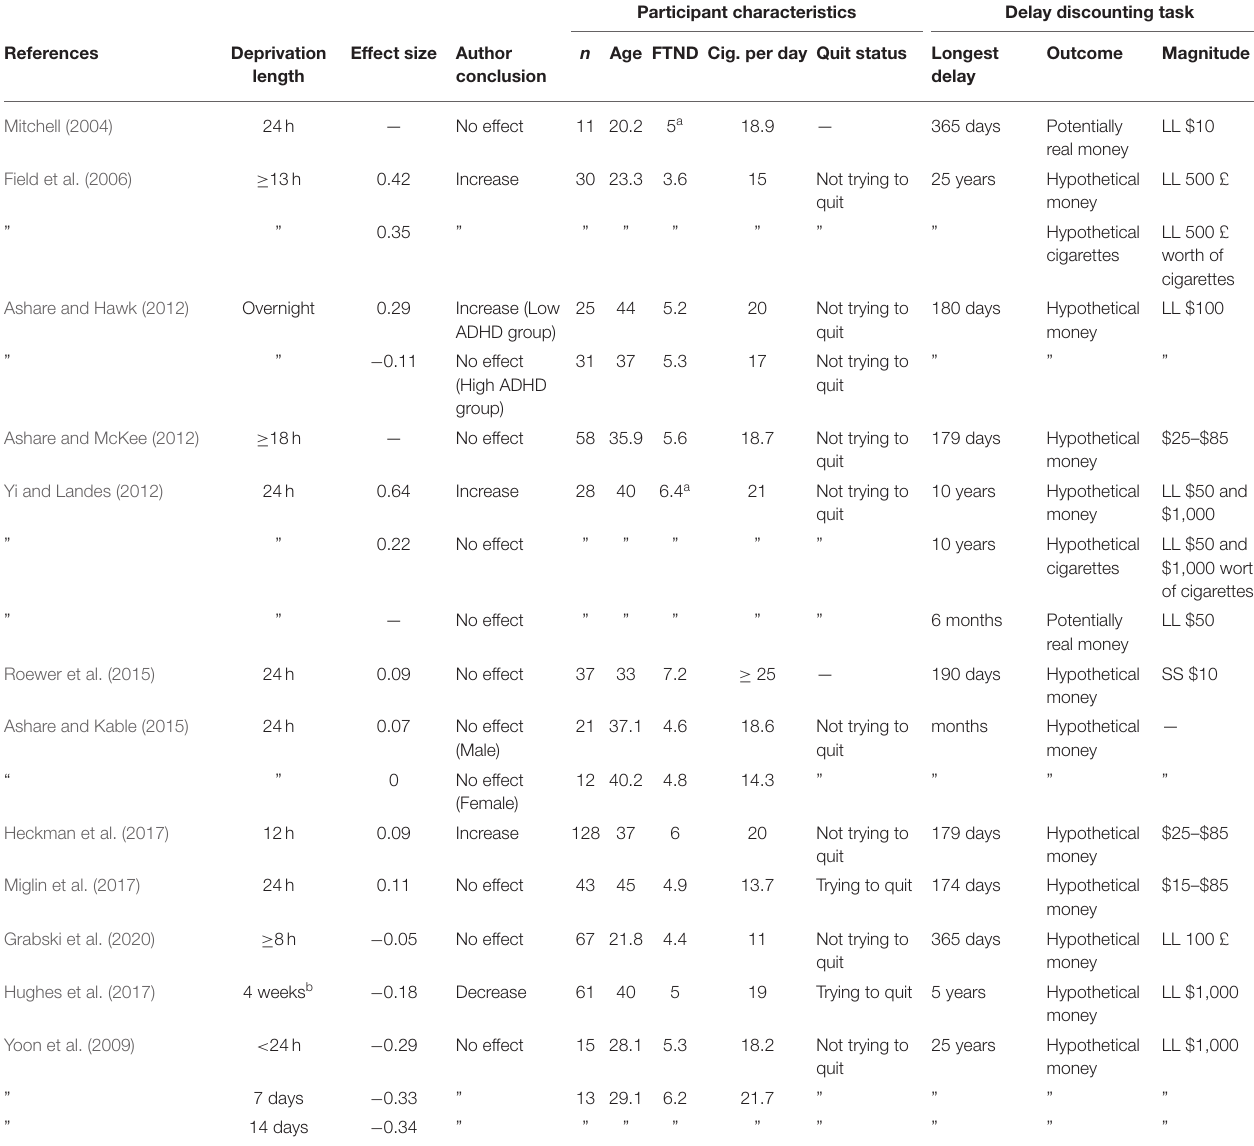
TABLE 1 | Comparison of participant characteristics and delay discounting tasks in nicotine deprivation